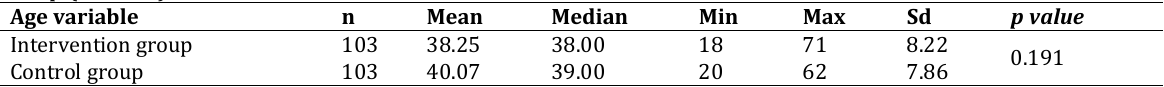
Table 2 Distribution of the Parents/Guardians of the Students by Sex and Level of Education in both the Intervention and Control Group (n = 206) Variable Male Total